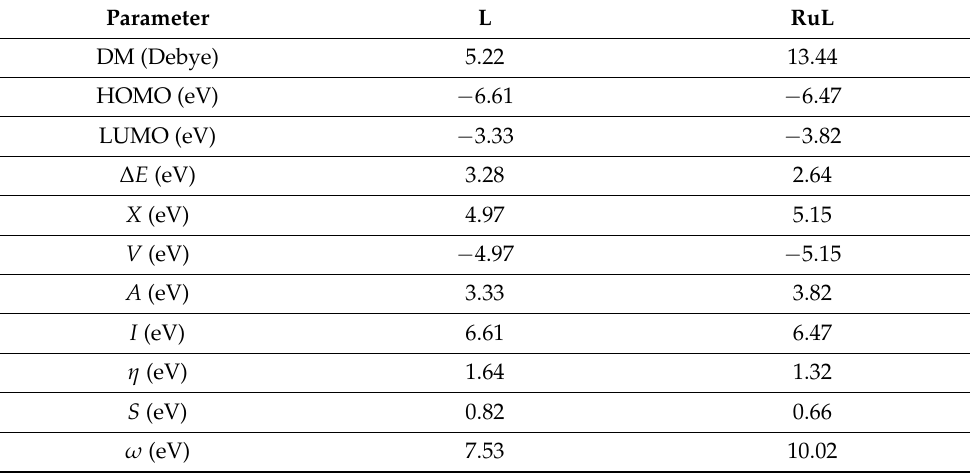
Table 2. The quantum global reactivity descriptors for the L and RuL